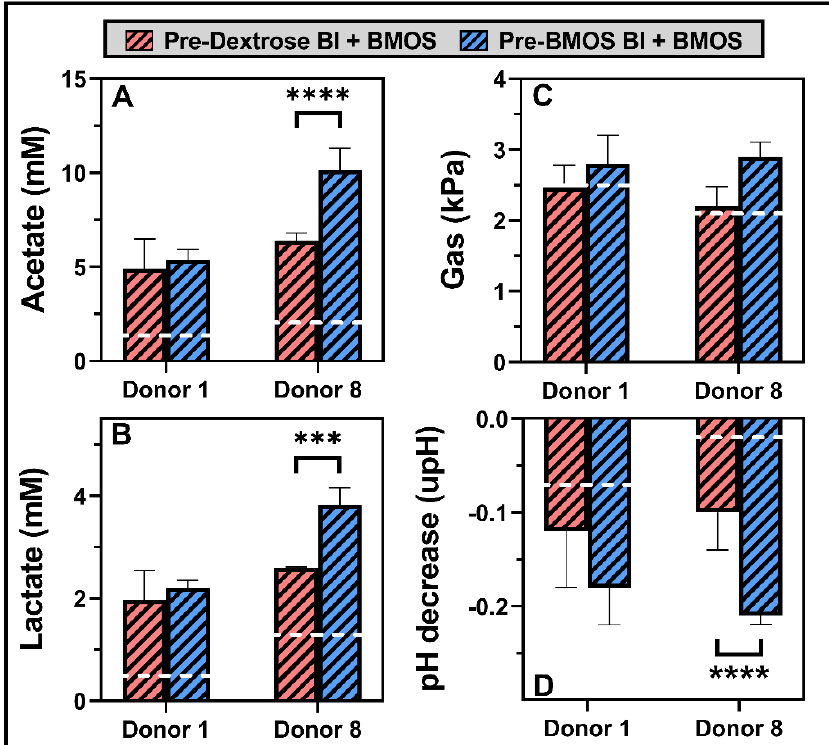
Figure 5. Mean ( ± standard deviation) microbial metabolic activity in terms of acetate production (mM) ( A ), lactate production (mM) ( B ), gas production (kPa) ( C ) and pH decrease (upH) ( D ) upon a 6 h fermentation of 5 g/L BMOS containing 1.5 × 10 7 CFU/mL of B. lactis previously grown on either